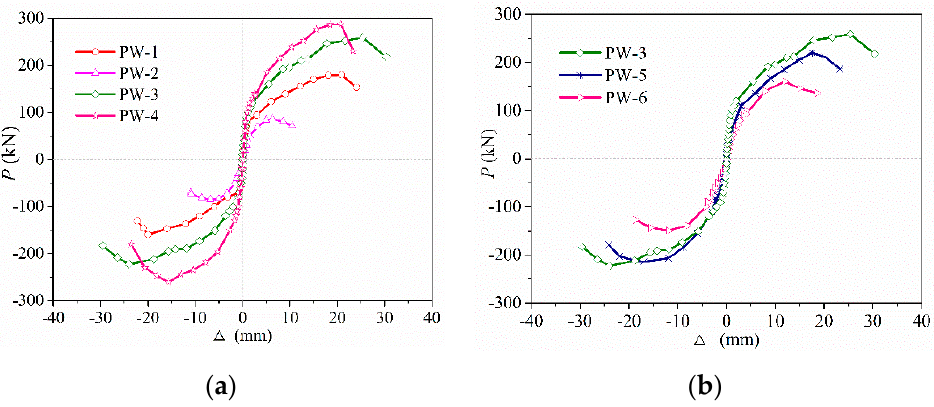
Figure 11. Skeleton curves of PW1-PW6: ( a ) PW1-PW4 specimens; and ( b ) PW3 and PW5-PW6 specimens.